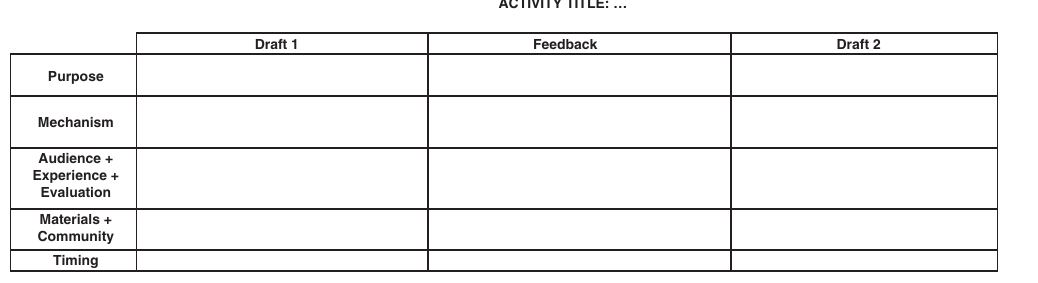
figure 5: activity design template (credit: charlotte R.